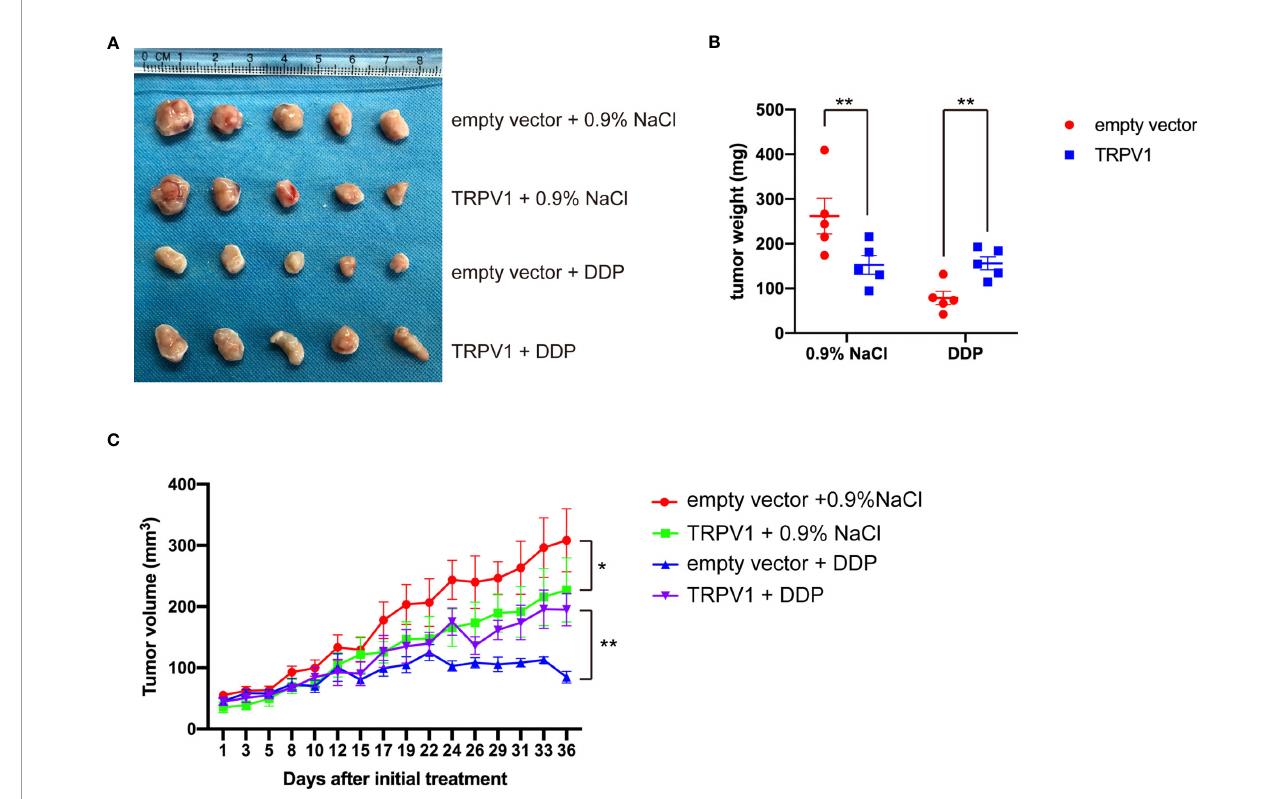
FIGURE 3 | TRPV1 overexpression induced DDP resistance in a mouse xenograft model. (A) Images of A549 empty vector and A549-TRPV1 xenografts treated with or without DDP. (B) The tumor weight of animals with A549 empty vector and A549-TRPV1 xenografts treated with or without DDP. (C) The tumor volume of A549 empty vector and A549-TRPV1 xenografts treated with or without DDP. Data represent mean ± SEM; * P < 0.05. ** P <